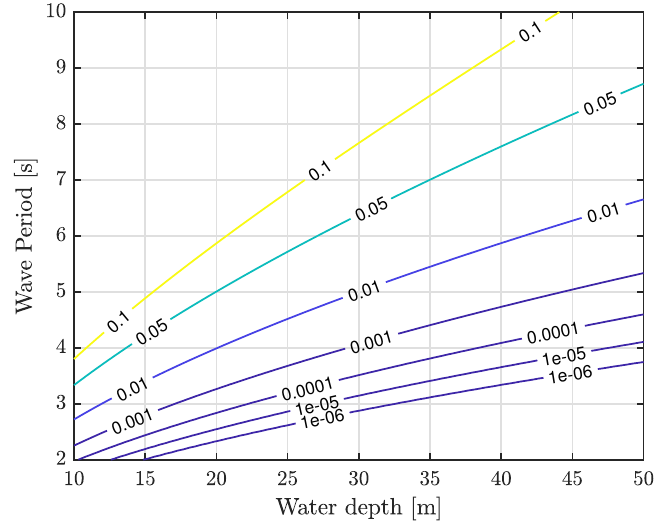
Figure 10. Contours of | u orb | / H s against water depth and wave